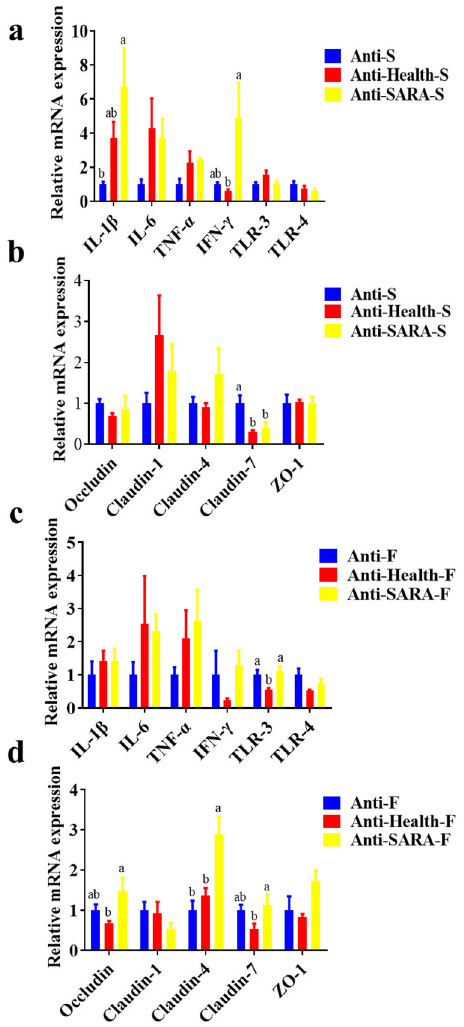
Fig. 7 Effects of ruminal microbe transplantation (RMT) on colon in fl ammation and intestinal epithelial permeability of antibiotic- treated mice. a The relative mRNA expression of cytokines and b tight junction proteins in the colon epithelia in antibiotic-treated mice receiving a high starch diet after RMT. c The relative mRNA expression of cytokines and d tight junction proteins in the colon epithelia of antibiotic-treated mice fed with a high fi bre diet after RMT. The data were analyzed using the ANOVA test. If a signi fi cant treatment effect was observed by ANOVA, the signi fi cant difference between treatments was identi fi ed by Duncan ’ s multiple compar- isons test. Anti: mice taking antibiotics; Health: mice infused by intragastric gavage with rumen fl uid from healthy dairy goats; SARA: mice infused by intragastric gavage with rumen fl uid from SARA dairy goats; S: high starch diet for mice; F: high fi bre diet for mice. a-b Mean values within an index with the same superscript letters indicated no signi fi cant difference ( P < 0.05). Error bars on the graphs represent standard